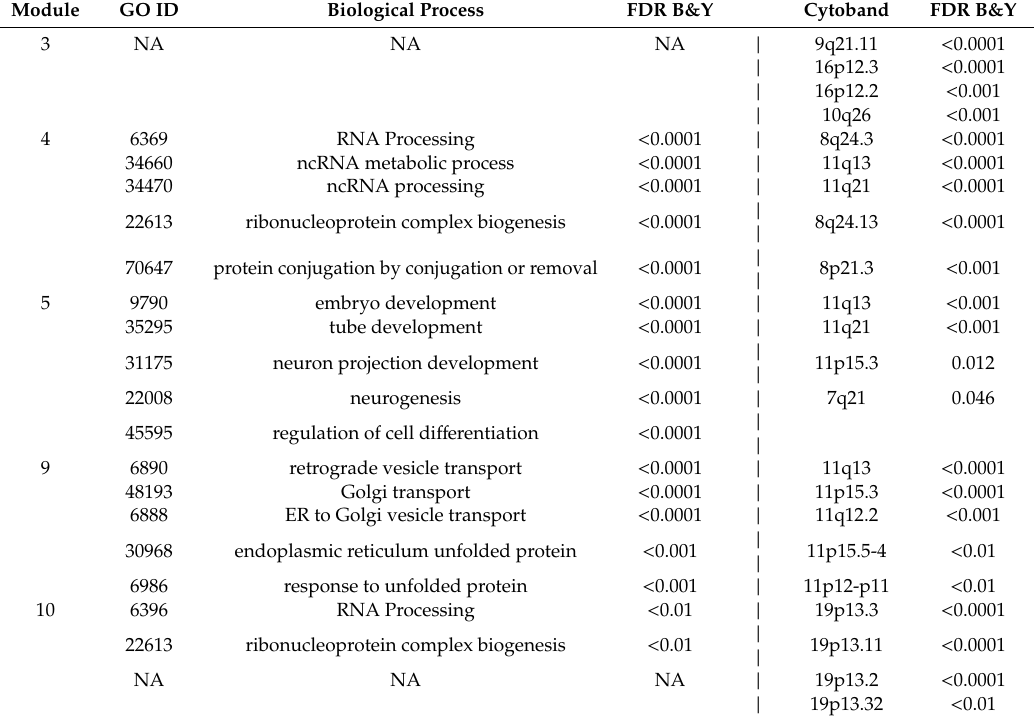
Table 2. Gene list enrichment analysis of biological processes and cytoband locations 5 largest di ff erentially co-expressed gene modules in fusion negative and fusion positive samples (See Table S2 for all di ff erentially co-expressed modules). Module 3 was upregulated, whereas Modules 4, 5, 9, and 10 were